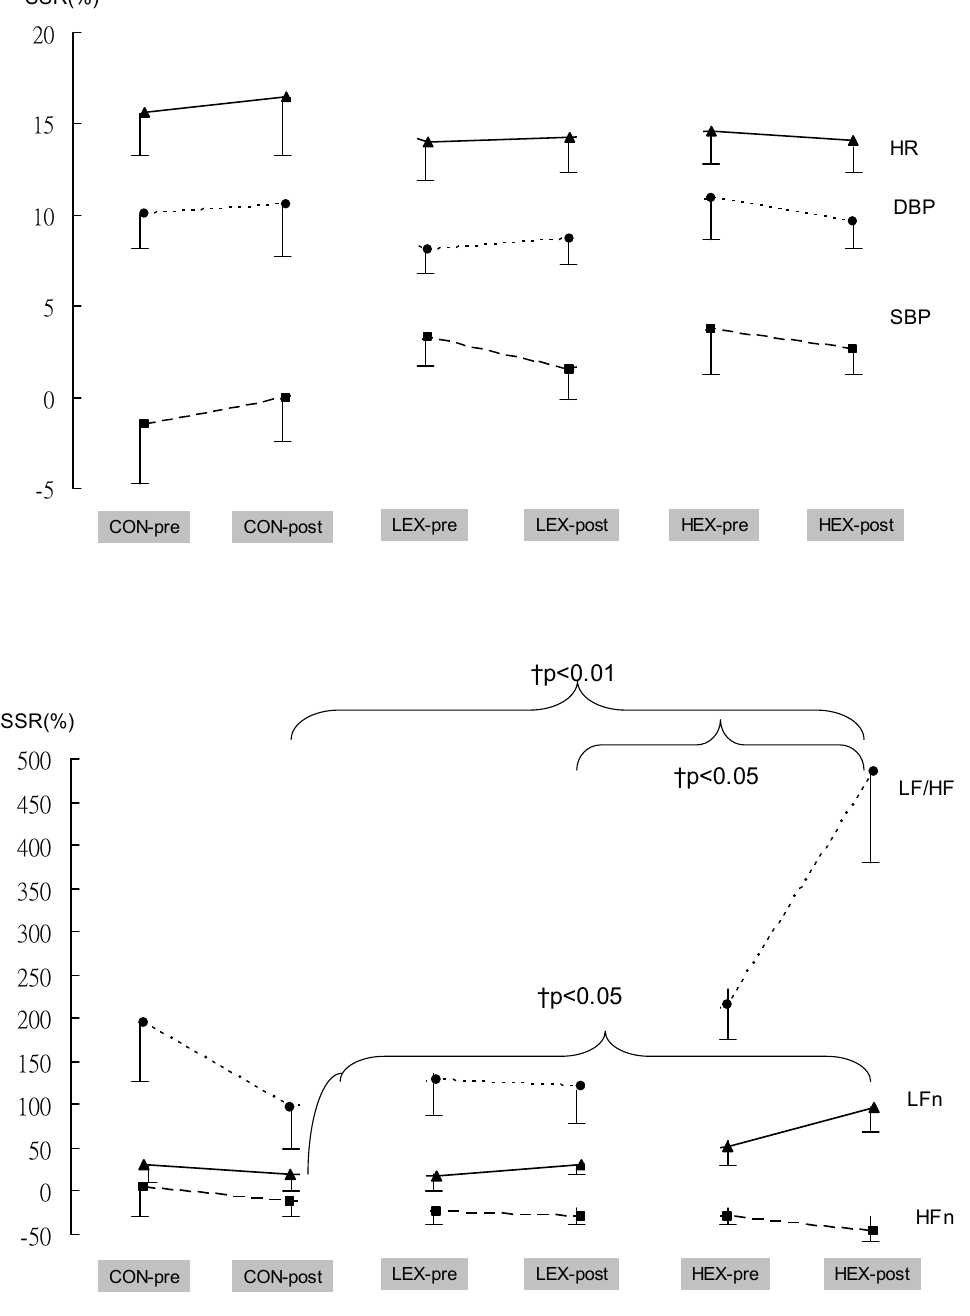
Figure 2. Changes in supine–standing ratio (SSR) as percentage differences between cardiovascular parameters and HRV parameters in pre- and post-study measurements for the three groups. HFn = HF power in normalized units; LFn = LF power in normalized units; HR = heart rate; SBP = systolic blood pressure; DBP = diastolic blood pressure. † p < 0.05, vs. LEX or CON by analysis of covariance with pre-training level and age as covariates.